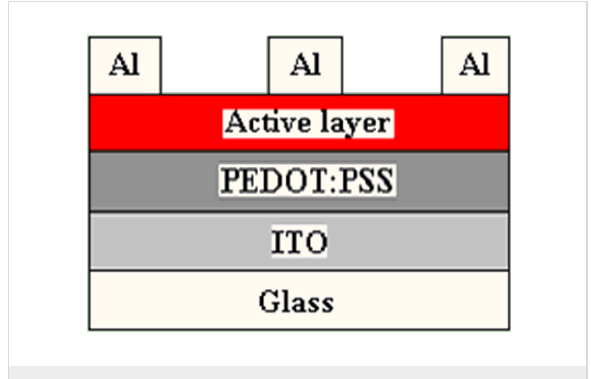
Figure 2: Device layout of the solar